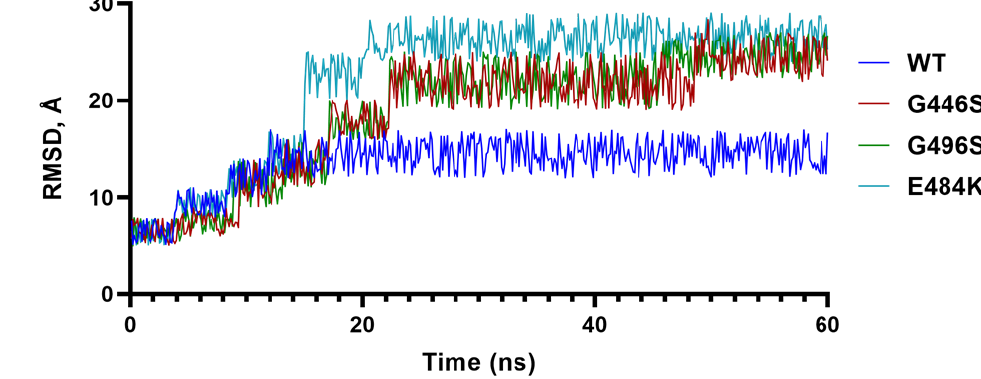
Figure 2. Molecular dynamics simulation. Trajectory of the root-mean-square deviation of S-RBD C α -atoms of E484A, G446S/G496S and G446/G496 over 100 ns MD simulations.